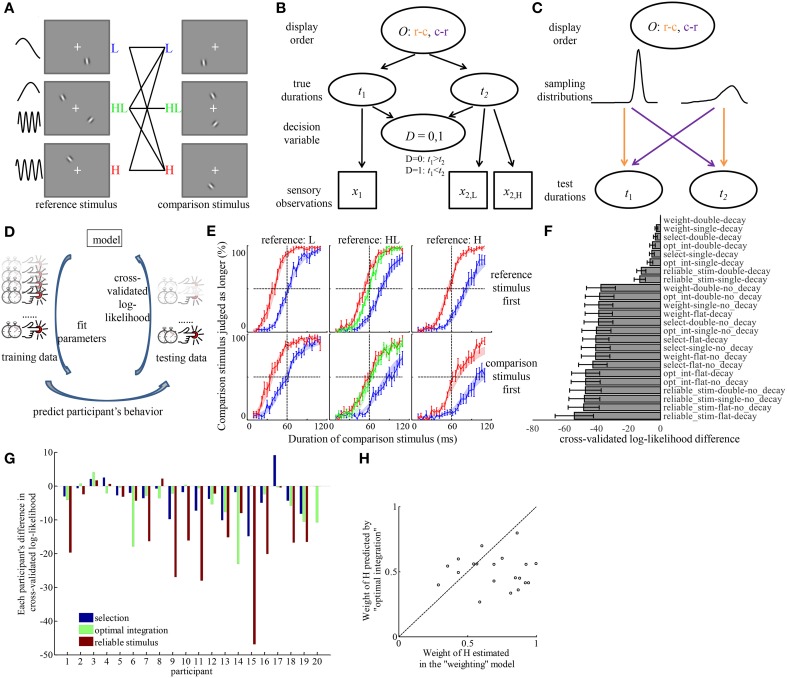
Model comparison provides quantitative evidence for the “weighting” hypothesis and identified the source of the discrepancy in psychometric curves corresponding to different order of displaying reference and comparison stimuli. (A) All the conditions tested in Experiment 3. Each condition corresponds to one solid line in the middle, connecting reference, and comparison stimuli. The order in which reference and comparison stimuli were displayed was random. (B) The generative model of an example trial for inferring the relation between two durations, if a participant considers the full structure of the task. O, order of display; c-r, comparison stimulus was displayed before reference stimulus; r-c, reference stimulus was displayed before comparison stimulus; t1, t2, durations of the first and second stimuli; x1, x2, sensory measurement of the first and second duration based on the stimuli; x2, H, x2, L, sensory measurements of the second duration, based on its H and L element, when the stimulus type is HL; D, decision variable indicating the relation between t1 and t2. (C) Illustration of how O decides the way t1 and t2 are sampled from two different distributions corresponding to the reference and comparison stimuli. The colors of the arrows correspond to the respective orders of display O. (D) The workflow of model comparison. Each model is fitted to part of a participant's trials (training data) to find the combination of parameters that maximized the probability of those trials. The fitted parameters are used to predict the behavior in the rest of the participant's trials (testing data). The probability of the testing data assuming the parameters fitted to the training data are logarithmically transformed to calculate the cross-validated log-likelihood. This procedure is repeated by rotating the selection of testing data over each of the 1/12 portion of the data. Models are compared based on the sum of cross-validated log-likelihood over all the data. (E) Average psychometric curves. Figures in the same column correspond to conditions of the same type of reference stimuli. Figures in the same row correspond to the same order of display. Color codes for the type of comparison stimuli. Shaded areas represent the fitted choice probabilities in each condition (mean ± s.e.m) by the best model in (F). (F) The difference of cross-validated log-likelihood of each model compared to the best model. “weight,” weighting hypothesis; “select,” selection hypothesis; “opt_int,” optimal integration hypothesis; “reliable_stim,” reliable stimulus hypothesis; “flat,” flat prior hypothesis; “single,” single prior hypothesis; “double,” double priors hypothesis. (G) With individual variability, “weighting” model outperforms each of other models in most participants. The bars represent the differences of the cross-validated log-likelihood of the best models assuming each hypothesis regarding the mechanism of forming the representation of duration for HL stimulus, compared to that of the best model assuming “weighting” hypothesis. A negative bar indicates the model is inferior to the “weighting” model. Each group of bars corresponds to one participant. (H) Participants tended to overweight the duration estimate based on H stimulus. The coordinates of each dot correspond to the weight of H estimated in the “weighting” model and the weight of H predicted by the “optimal integration” model for each participant.